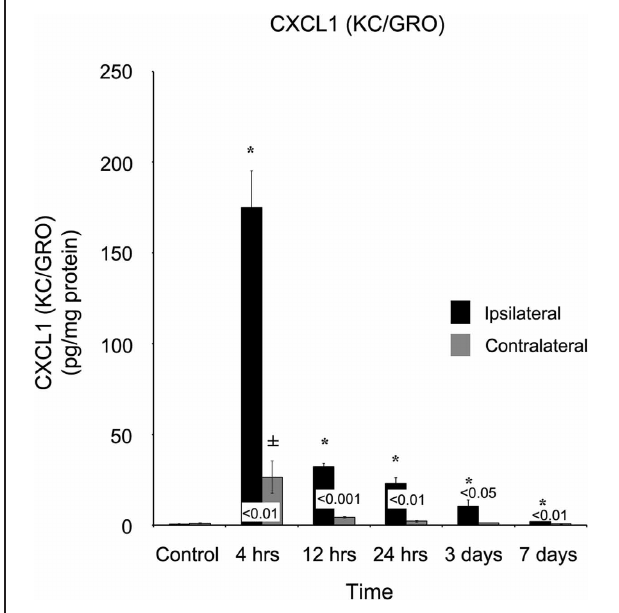
FIGURE 1 | CXCL1 (KC/GRO) concentrations increase in both the ipsilateral and contralateral cortex following a controlled cortical impact. Within four hours of a brain injury, CXCL1 increases ( p < 0 . 05) in both the ipsilateral and contralateral cortex in comparison to control. In comparison to both control and contralateral tissue, the ipsilateral hemisphere continued to express elevated ( p < 0 . 05) concentrations for three days. In contrast, the contralateral cortex only demonstrated an elevated expression ( p < 0 . 05) at four hours, returning to normal levels by 12 hours. All values are mean ± SEM, n = 5. ∗ At each time point noted, ipsilateral differs from control tissue, p < 0 . 05. ± At each time point noted, contralateral differs from control tissue, p < 0 . 05. Differences between the ipsilateral and contralateral cortices are denoted by placing the appropriate p -value above the two